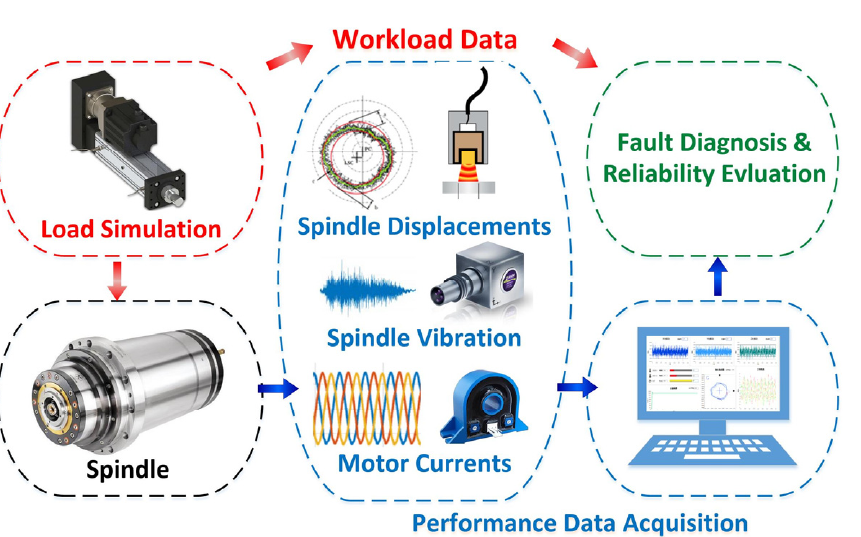
Figure 17. Condition monitoring of spindle reliability